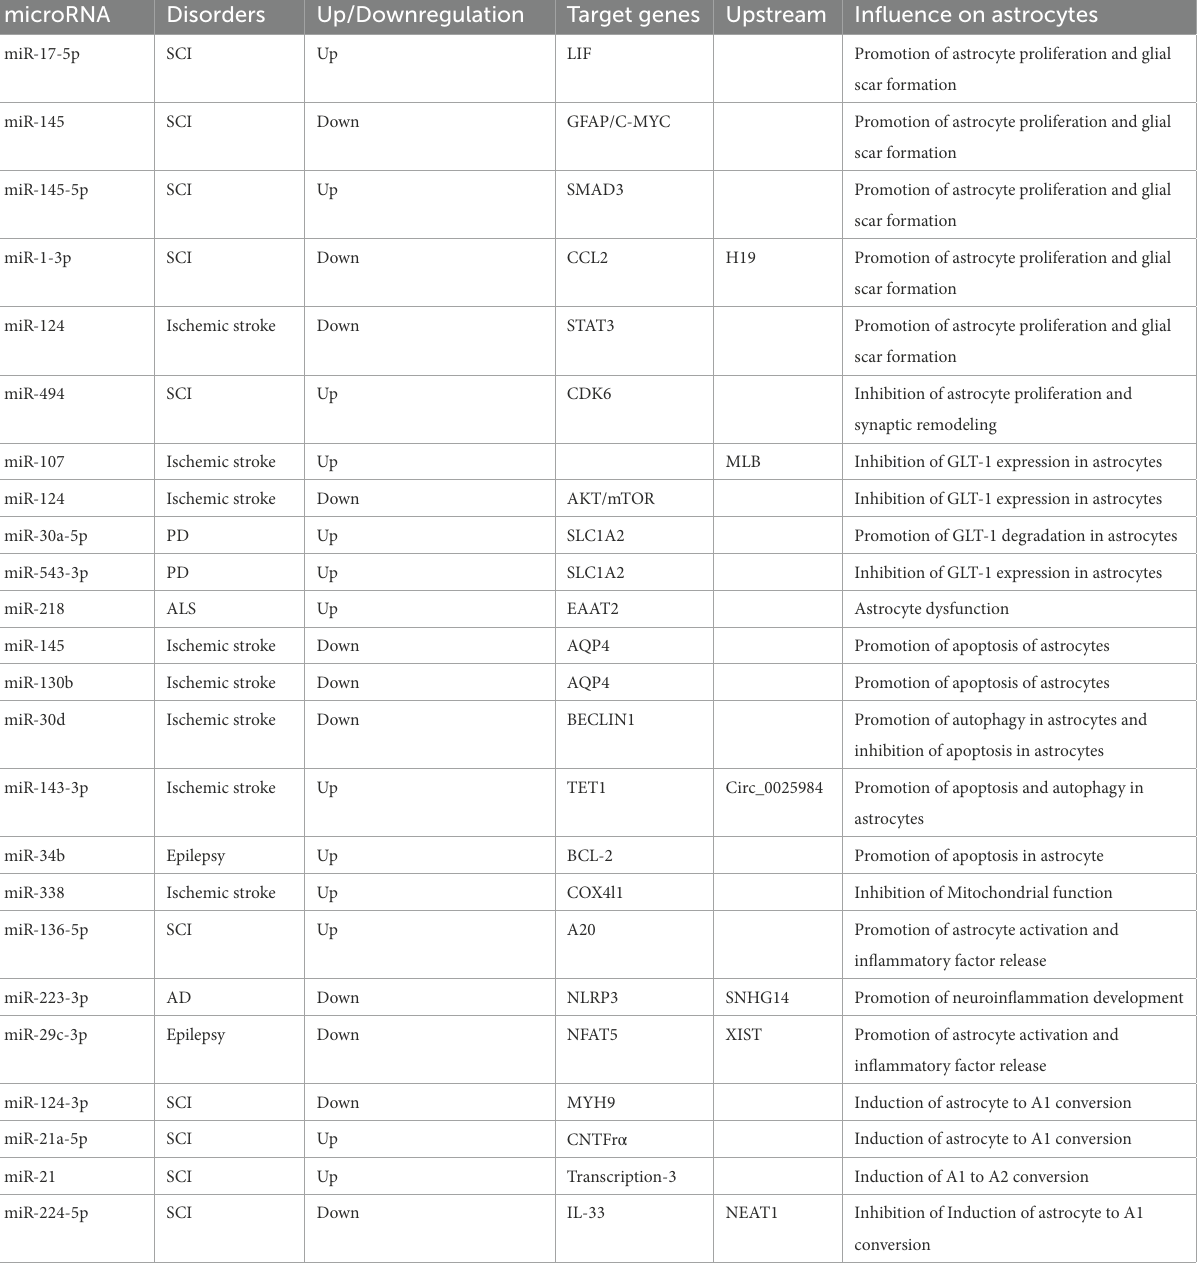
TABLE 1 Characteristics of miRNA involved in astrocytes in Neurological